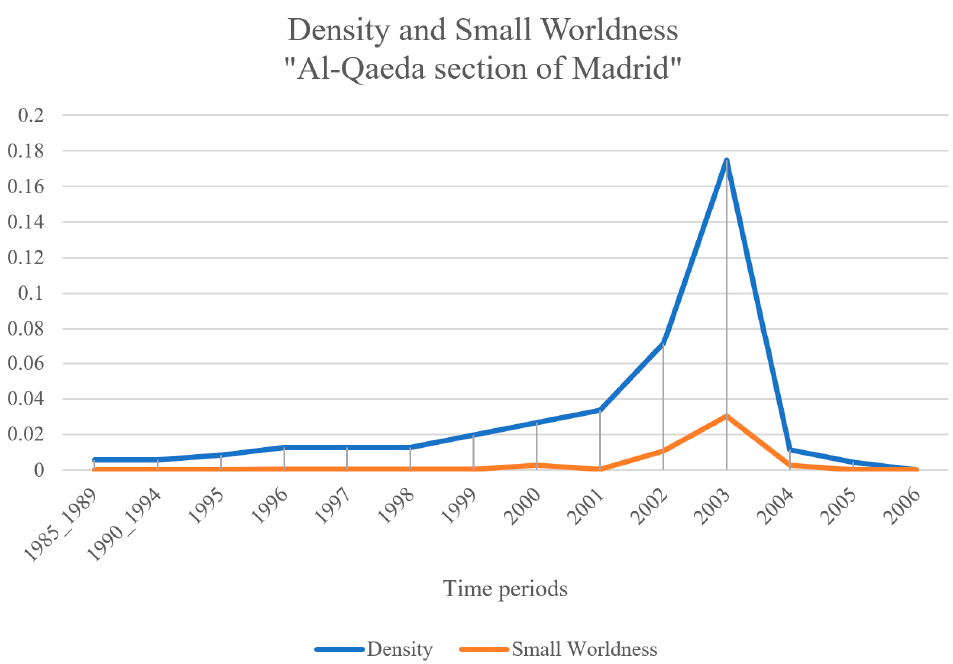
Figure 7. Temporal development of density and small worldness for the “Al-Qaeda section of Madrid”. Both indices reach a maximum in 2003, increasing rapidly after 2002 and falling rapidly after the maximum value in 2003. Afterwards, both indices decrease slowly till 2001, and then decrease rapidly. The observed temporal increase in 2003 is more or less the same for both (about 200% for the small woldness and 200% for density).